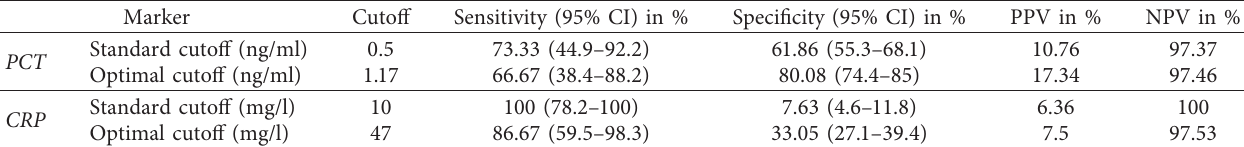
Table 4: Sensitivity and cutoff level of PCT and CRP at fixed specificities between bacteremia and nonbacteremia groups. Table 5: Sensitivity and specificity and PPV and NPV of CRP and PCTmarkers to distinguish bacteremia from nonbacteremia at optimal cutoff in comparison with standard cutoff based on ROC curve results. Standard cutoff (ng/ml) PCT Optimal cutoff (mg/l)